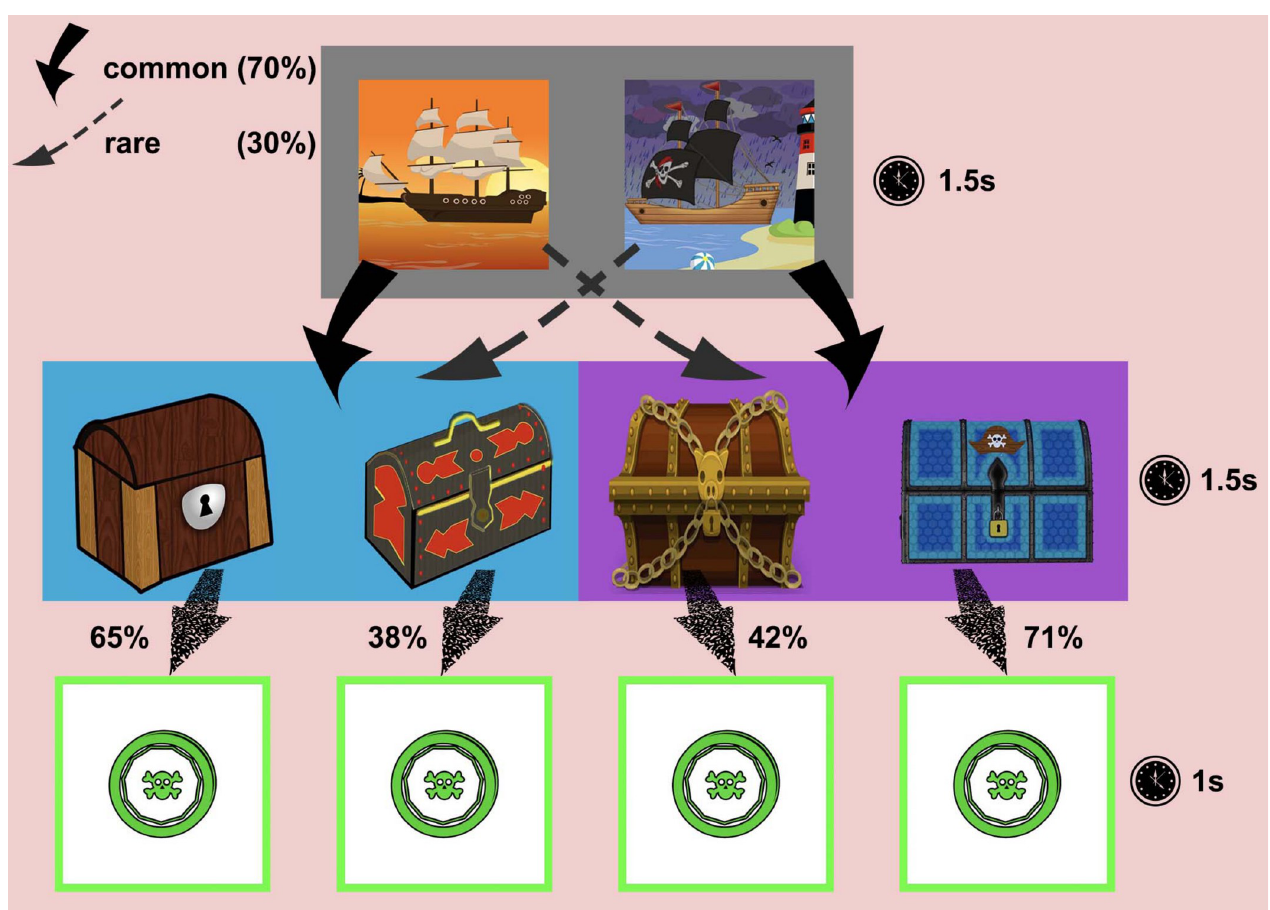
Fig 1. The structure of the two-step decision-making task. In the first stage (grey), a dashed arrow corresponds to a rare transition with the probability of 30%, while the bold arrow corresponds to a common transition with the probability of 70%. In the second stage, the speckled arrow is associated with the probability of receiving a reward. The duration of each stage is noted to the right (stage one, stage two, reward).